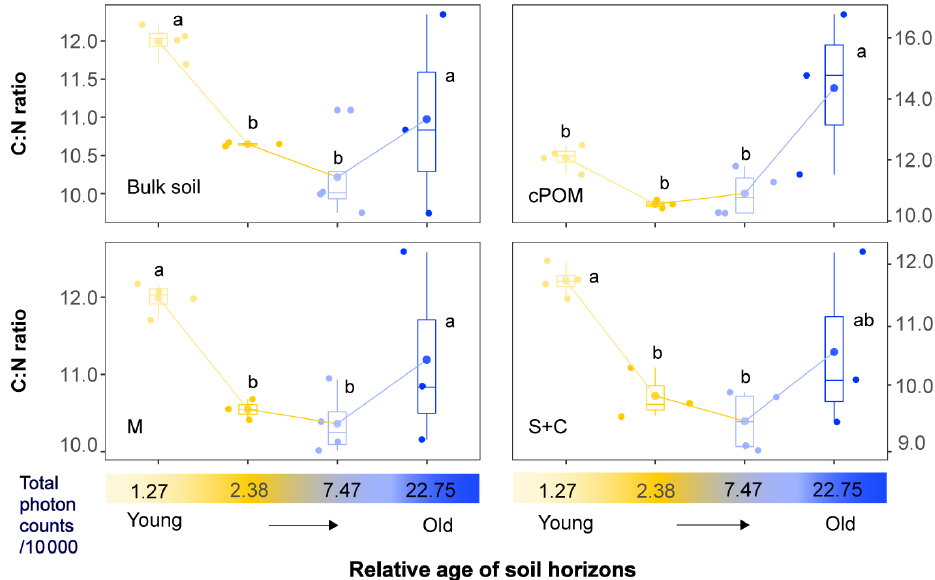
Figure 7. Boxplots of C : N ratios for bulk soil and SOC fractions along the gradient of terrace soil burial age (total photon counts). cPOM = coarse particulate SOC; M = microaggregate-associated SOC and S + C = silt- and clay-associated SOC. Significant differences in C : N ratios between soil age gradients were indicated by different lowercase letters ( P <